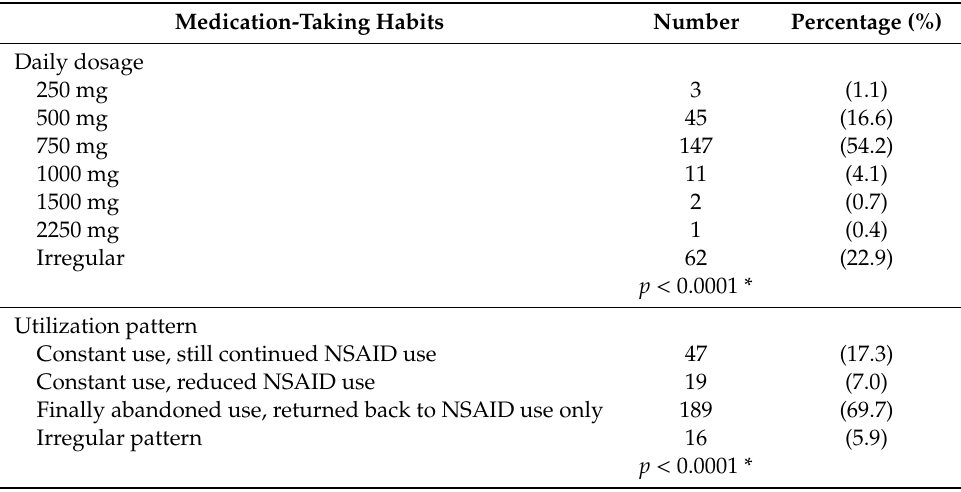
Table 5. Medication-taking habits of glucosamine sulfate from 2005 to 2008 ( n = 271).